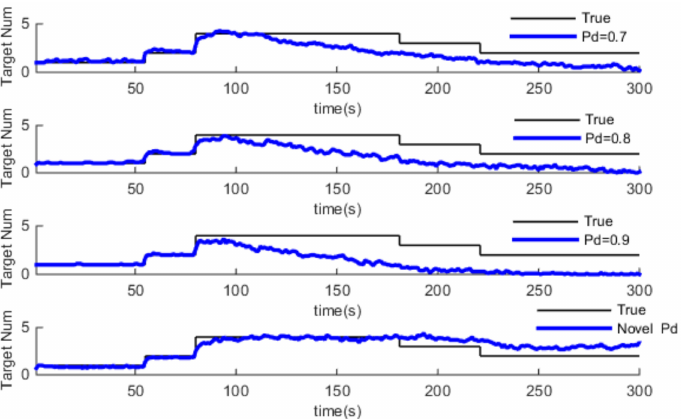
Figure 11. Comparison of target number estimation with different P d in clutter intensity κ k = 20.